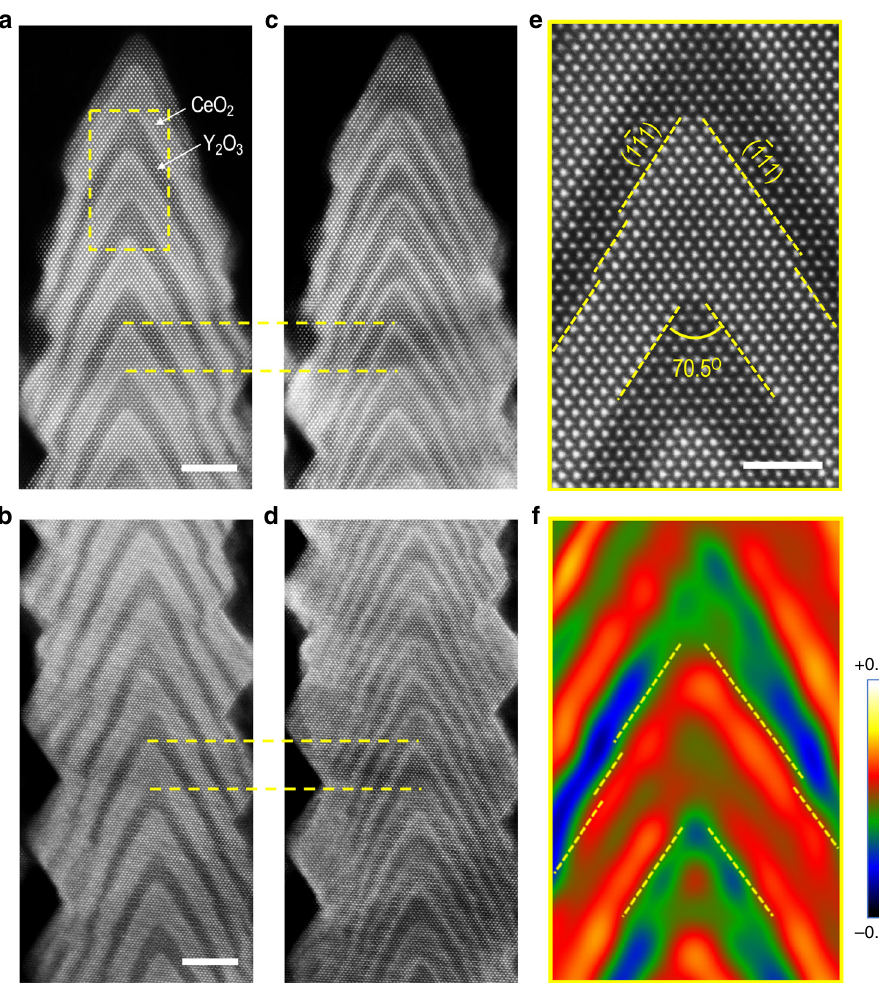
Fig. 2 (111) interface and local strain in a free-standing CeO 2 /Y 2 O 3 nanobristle. a , b HAADF images and c , d their corresponding LAADF images taken from the top and middle regions of a free-standing CeO 2 /Y 2 O 3 nanobristle along the [110] direction. As indicated by the yellow dashed lines, the brighter contrast at the outer parts of the CeO 2 sublayers in the LAADF images suggests locally enhanced lattice distortions due to the formation of oxygen vacancies. The scale bar corresponds to 5 nm. e Magni fi ed HAADF image showing atomically abrupt interfaces and {111} Ce facets between CeO 2 and Y 2 O 3 layers. The scale bar corresponds to 2 nm. f Geometric phase analysis of the HAADF image shown in e reveals a lattice expansion of the outer parts of the CeO 2